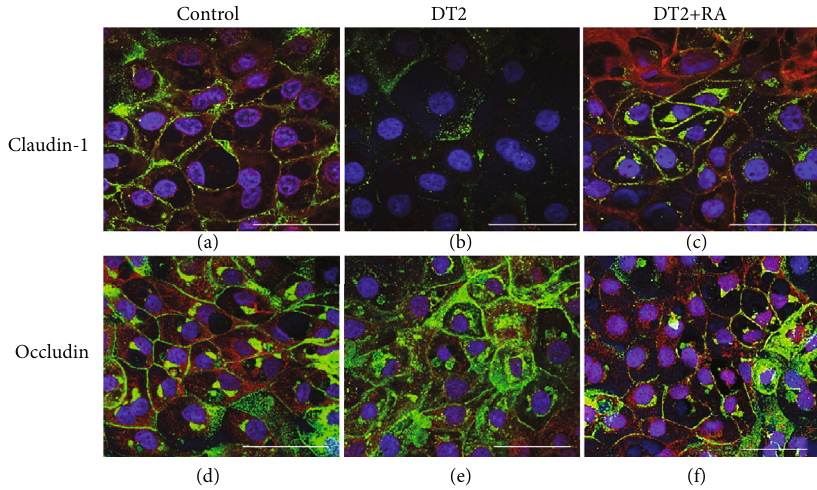
Figure 6: E ff ects of DT2 and DT2 + RA (RA pretreatment for 24 h) on the localization pattern of (a – c) claudin-1 and (d – f) occludin using immuno fl uorescent staining. Di ff erentiated IPEC-J2 cells were cultured on membrane inserts for 10 days then were exposed to DT2 ( 1 μ mol/L DON + 5nmol/L T − 2 ) or to DT2 + RA ( 1 μ mol/L DON + 5 nmol/LT − 2 + 50 μ mol/L RA ); both treatments were applied apically and basolaterally for 72h. Cells were stained for occludin and claudin-1 (Alexa Fluor 546, red). Cell nuclei were stained with DAPI (blue), and cell membranes were labelled with wheat germ agglutinin (Alexa Fluor 488, green). In controls and in DT2 + RA- treated samples, claudin-1 and occludin were colocalized with wheat germ agglutinin. White scale bar shows 50 μ